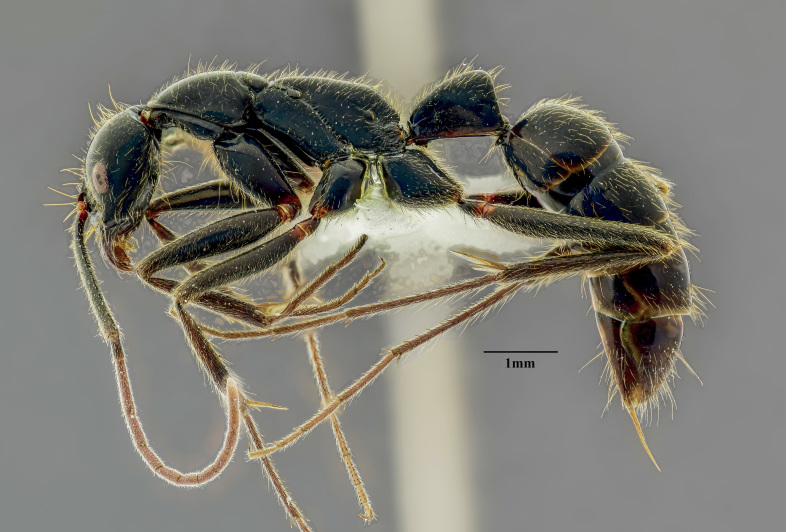
Body, lateral view